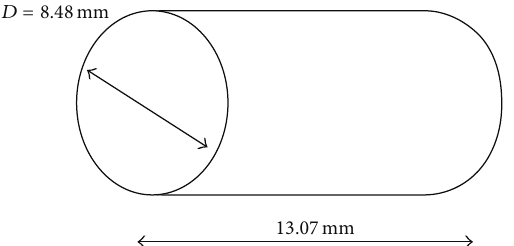
13.07 mm Figure 4: Schematic of the cylindrical AISI 4340 Steel pellet [17,